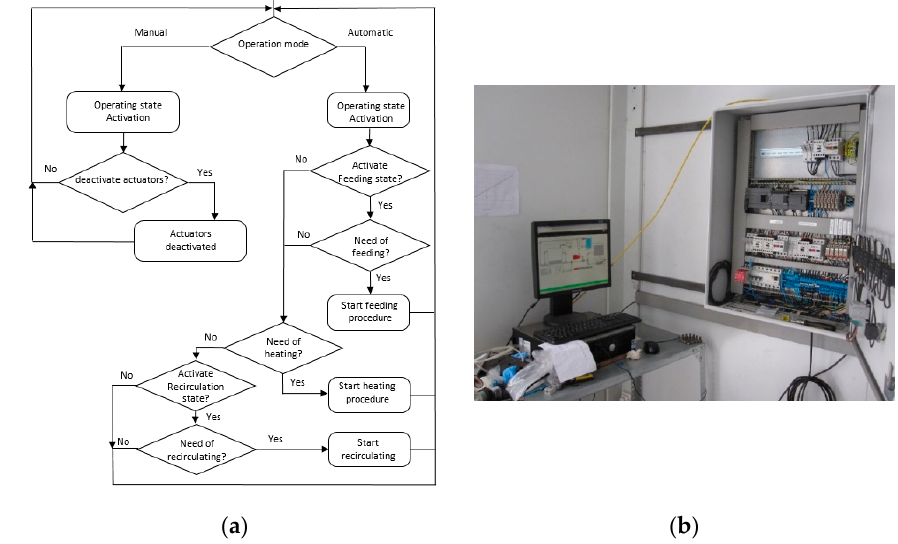
Figure 7. ( a ) Control flow chart of the process; ( b ) Control panel of the prototype located in the control house.